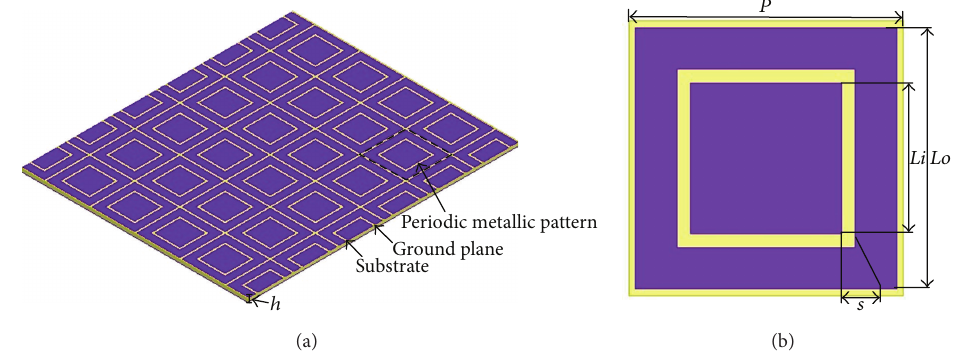
Figure 2: Layout of the AMC structure under investigation: (a) bird’s eye view, (b) unit cell.